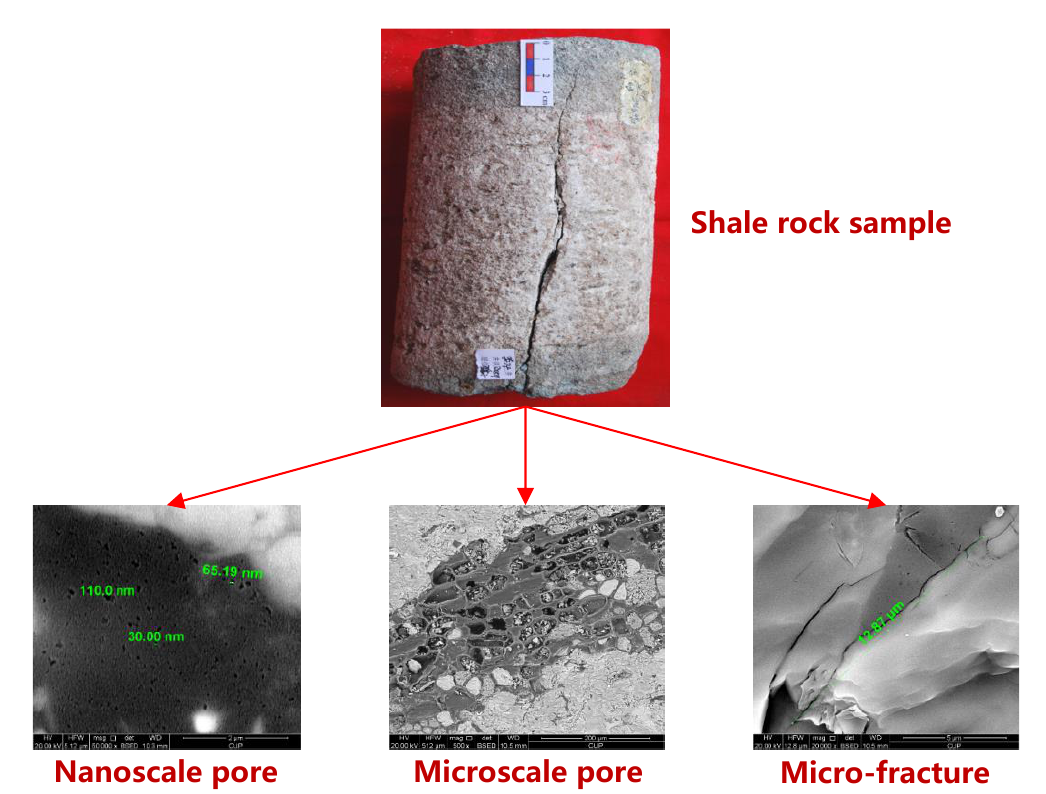
Figure 2. Microscopic pore structure of shales.